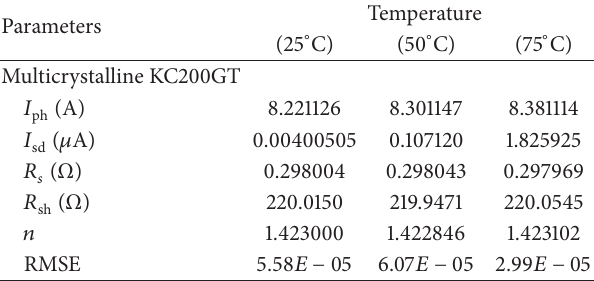
Table 15: The extracted parameters for multicrystalline KC200GT PV module by PCE at different temperatures and values of irradi- ance of 1000W/m 2 .